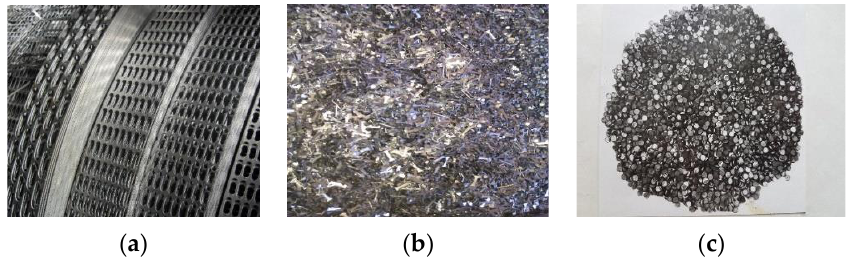
Figure 5. PMM waste: rolls of steel tape ( a ); after rough grinding ( b ); in the form of pistons ( c ).